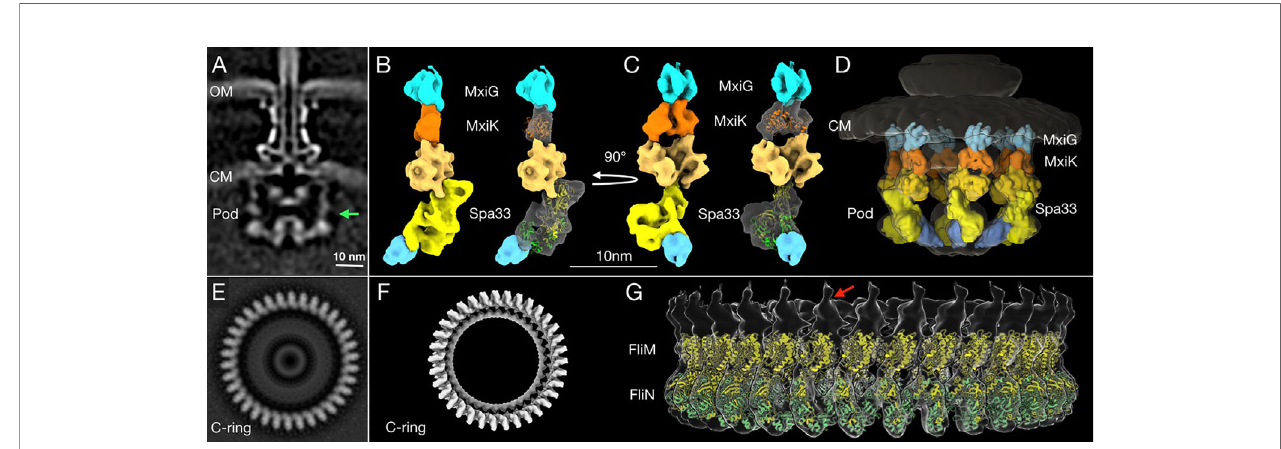
FIGURE 7 | High-resolution structure and proposed model of the in situ SP pods from Shigella . (A) A cross-section image of the subtomogram average structure of the injectisome shows (from top to bottom) the needle, basal body and SP. The two bacterial membranes are indicated by OM (the outer membrane) and CM (the cytoplasmic membrane). The green arrow indicates the right side of the pod region that was used for the additional re fi nement process to improve its resolution. (B) A 3D surface rendering image of the re fi ned pod structure is shown. From the top down, the re fi ned pod structure associates with the cytoplasmic domain of MxiG (blue) and consists of MxiK (orange) and multiple copies of Spa33 (different shades of yellow), which also associate with MxiN (cyan at bottom) (Hu et al., 2015; Tachiyama et al., 2019). The crystal structure of MxiK ’ s homologue from P. aeruginosa , SctK (Muthuramalingam et al., 2020) was fi t into the density beneath MxiG (right). Two copies of the Spa33 heterotrimer model were fi t into the bottom part of Spa33 region in the re fi ned pod structural image (right). Because this is a preliminary model, some regions did not fi t precisely into the cryo-ET image (see Supplementary Figure S15 ). The top of the proposed Spa33 density forms a globular structure that interacts with MxiK. (C) The same images are shown rotated 90° relative to (B) . This angle shows the single pod with a view that would be on the inside of the SP cage. (D) The re fi ned pod structure was fi t back into a 3D surface rendering of the complete SP. This image shows the six pods forming the cage-like structure of the SP. (E) A bottom view of a subtomogram average structure from the Vibrio alginolyticus fl agella C-ring (Carroll et al., 2020). The C-ring is composed FliM and FliN, which are homologous to Spa33 in the pod assembly. (F) A surface rendering of the C-ring with its 34-fold symmetry (EMDB-21837) was generated using the UCSF Chimera (Pettersen et al., 2004) and ChimeraX (Goddard et al., 2018) software. (G) A side view of the 3D surface rendering of the C-ring with a model of a full-length FliM (yellow) and three copies of FliN (green) from I-TASSER (Roy et al., 2010; Yang et al., 2015; Carroll et al., 2020) is shown. The red arrow indicates a single unit of the C-ring structure for comparison with the re fi ned single pod structure in (B, C)